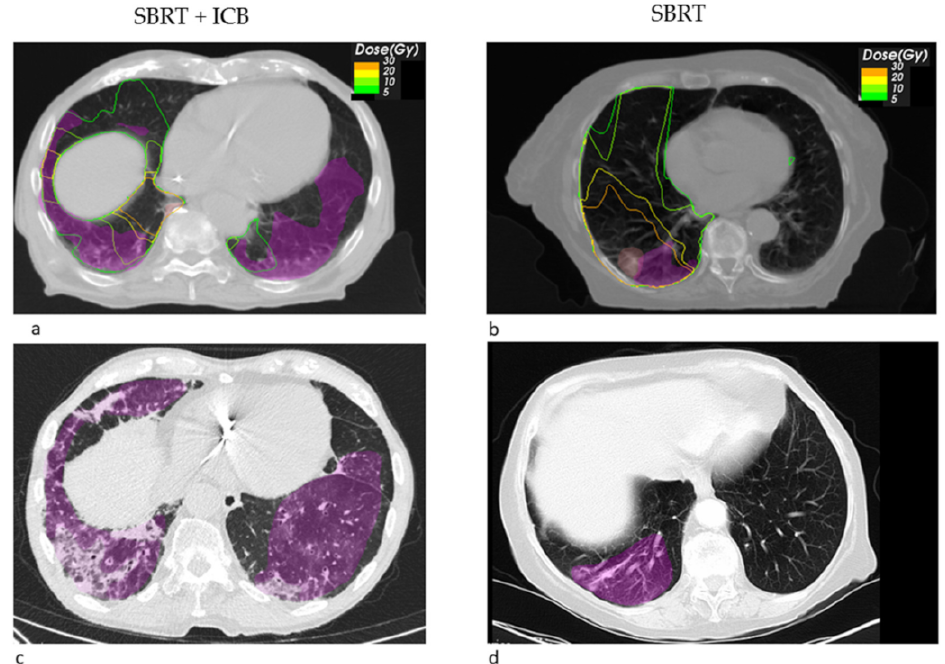
Figure 1. Transversal radiotherapy (RT) planning CT slices showing the EQD2 isodoses and pneu- monitis contours (magenta) and GTV contours (light red) for a SBRT + ICB case ( a ) and for a SBRT case ( b ). Exemplary transversal slices from the follow up CT showing the pneumonitis and its contours (magenta) for the SBRT + ICB case ( c ) and the SBRT case ( d